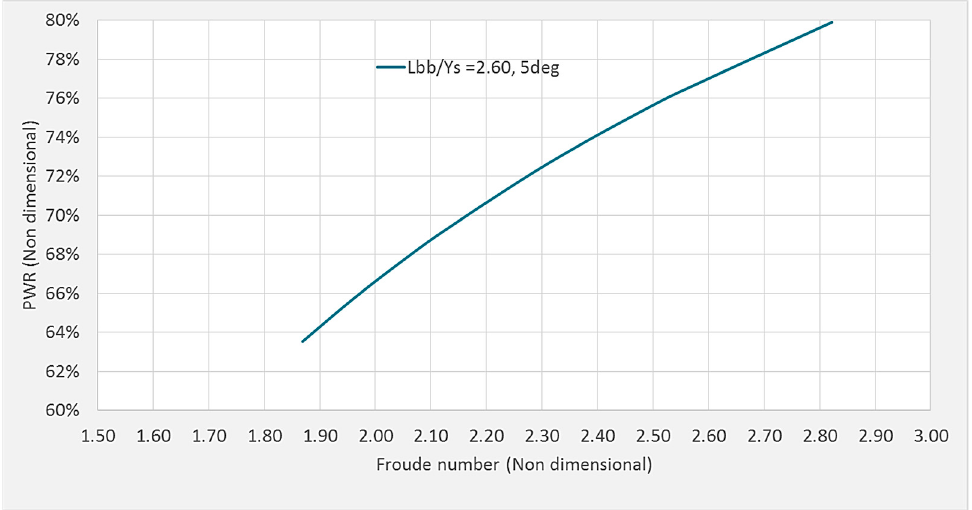
◦ pitch angle. Fluids 2019 , 4 , x FOR PEER REVIEW